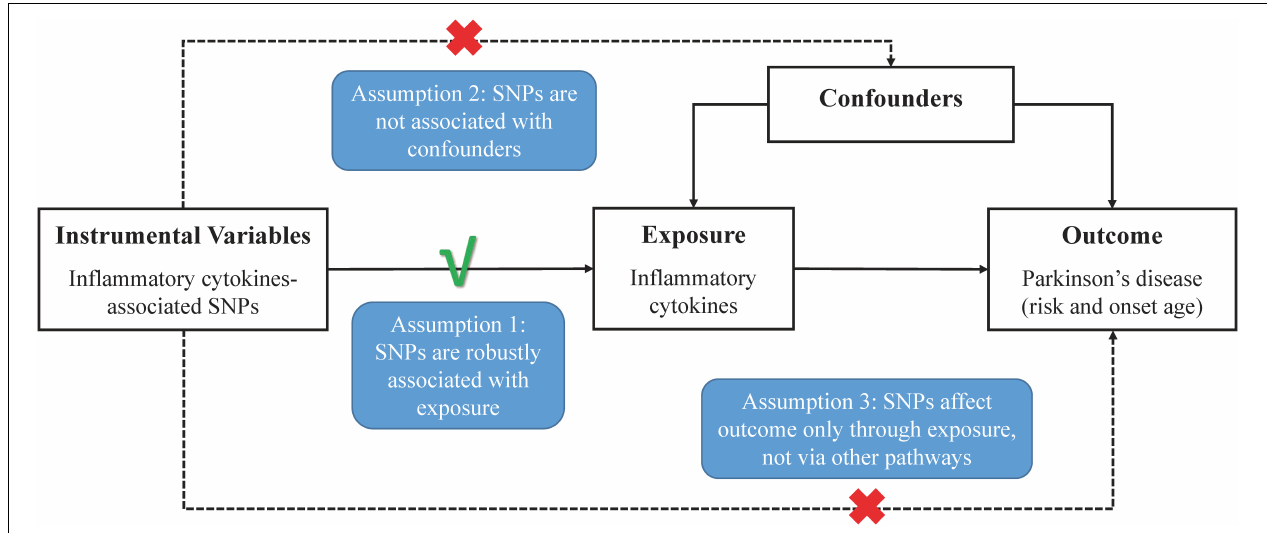
FIGURE 1 | Schematic representation of two-sample Mendelian randomization analyses for circulating levels of inflammatory cytokines and risk of Parkinson’s